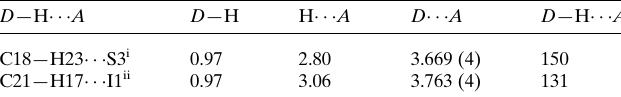
Table 1 Hydrogen-bond geometry (A˚ , (cid:5) ).